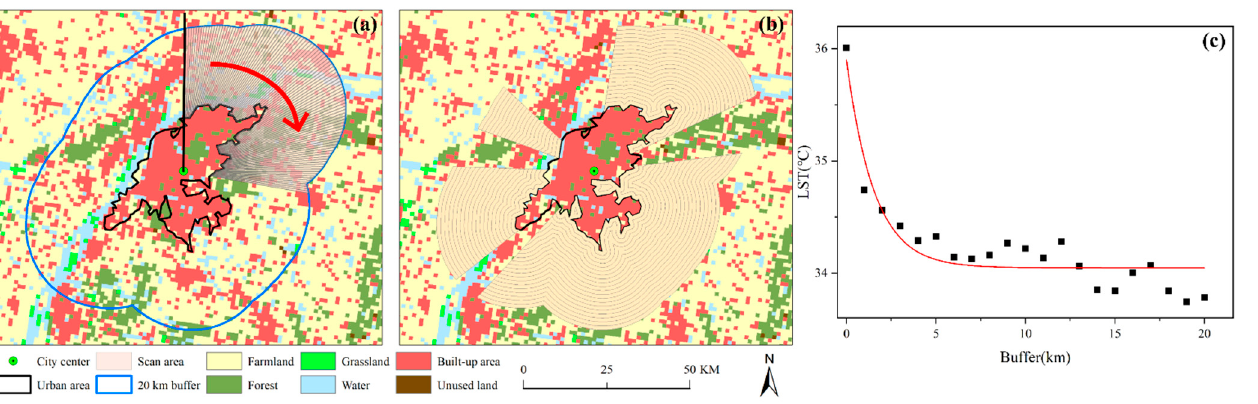
Figure 3. Schematic of the rotational scan and the suburban area obtained from the method. ( a ) Rotational-scan model; ( b ) selected suburban area and multiple ring buffers at 1 km intervals; ( c ) land surface temperature fitting curves of the selected suburban area.